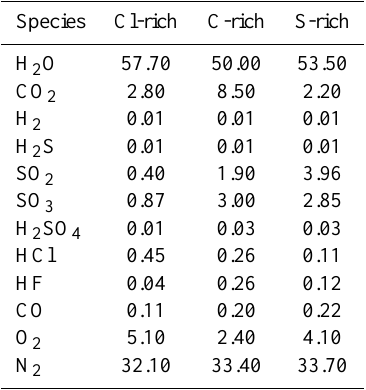
Table 3. Average volcanic gas composition entering the mid-T zone ( T = 600 ◦ C after mixing of 1000 ◦ C magmatic gas with ambient air) for convergent plate or Cl-rich, divergent plate or C-rich and hot spots or S-rich eruptions (concentrations are in mol%) (Hosh- yaripour et al., 2014). Cl-rich composition is used in the reference scenario. C- and S-rich compositions are used in the sensitivity